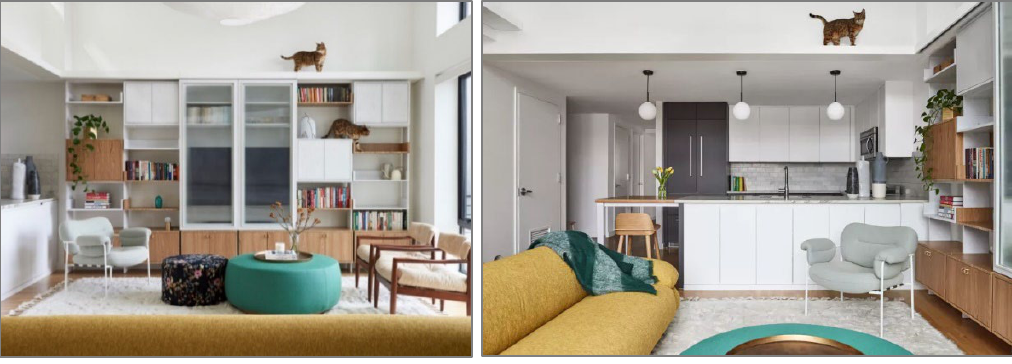
Figure 8 Interior design ceiling detail (URL-3)